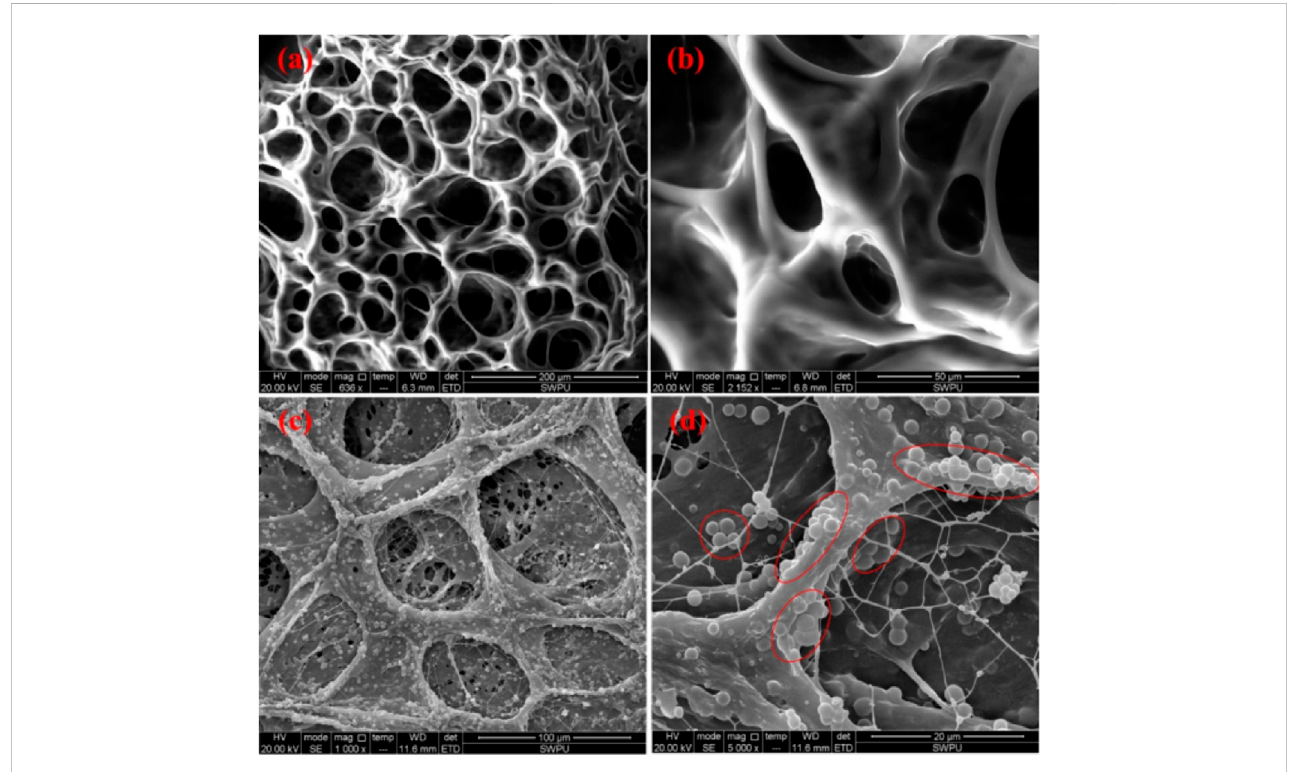
FIGURE 6 ESEMmicrographsofgelsamplespreparedwithdifferentconcentrationsofnano-silicaparticles. (A) , (B) Withoutnano-silicaparticles. (C) , (D) .2 wt%(Liu et al.,